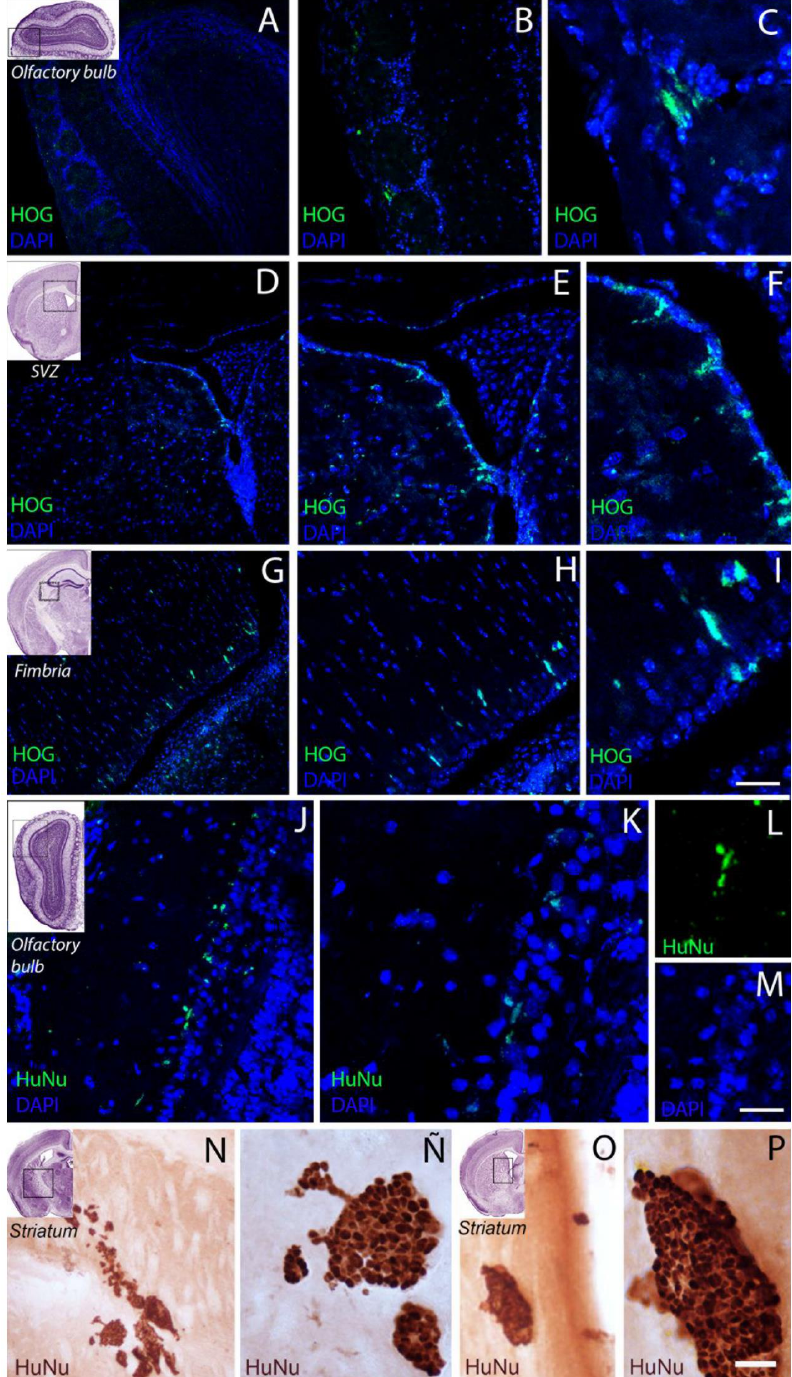
Figure 4. Representative confocal microscopy images of GFP-labelled HOG cells in different brain areas at 60 days after administration of dose 2. ( A ) In the olfactory bulb, HOG cells with small filopodia ( A – C ) were observed in the perigranular cell layer. ( D – F ) In the periventricular region, GFP-labelled HOG cells were observed near the ventricle; cell density was higher in the septum and ( G – I ) In septum, show a fusiform morphology. ( J – M ) HuNu-positive cells are shown in the olfactory bulb (image merge J , K ). In ( K ) the labeling is shown in more detail, the ( L , M ) images show the individual channels ( L ): HuNu 488 and M nuclei in DAPI. In the ( N – P ) images, HuNu + cells are shown by IHC-DAB, observing cells in the ventricular wall and in the striatum region, formed conglomerate cells Scale bar: HOG-GFP images ( A ) 250 µ m; ( B , D , G ) 100 µ m; ( E , H ) 75 µ m; ( C , F ) 40 µ m; ( G ) 50 µ m. HuNu ( I , F ) images: ( J ) 50 µ m; ( H , I , K , L ) 100 µ m; ( M ) 200 µ m. ( D , A , B ) images: ( N , O ) 120 µ m; ( Ñ , P ) 50 µ